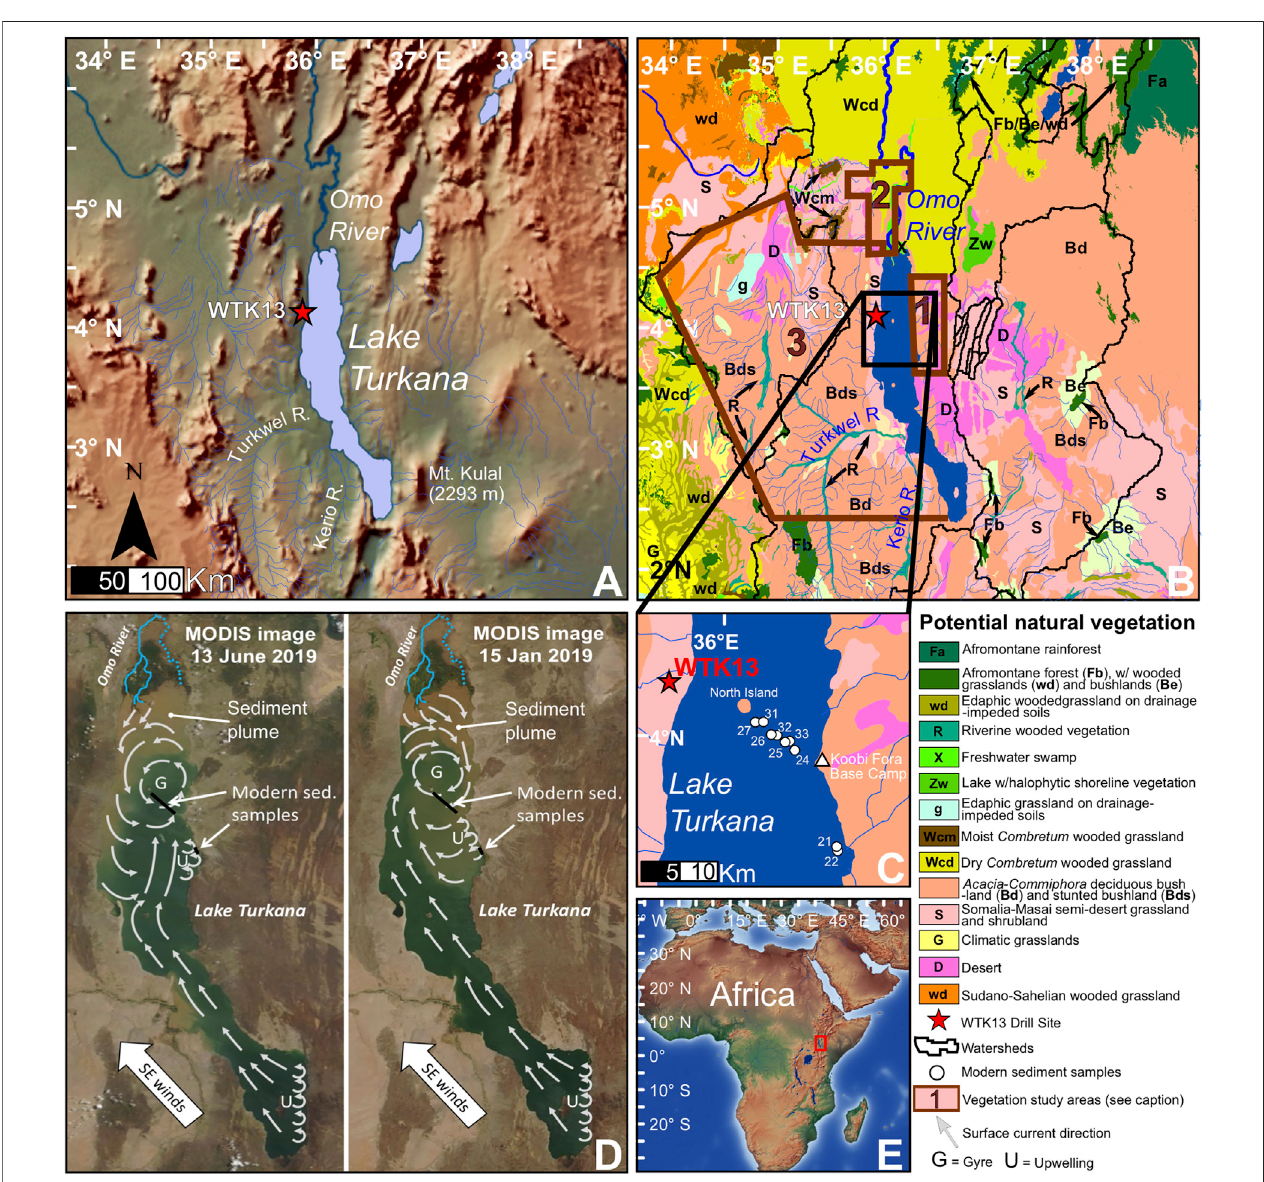
FIGURE 1 | Study area maps. (A) Colored relief map of the Turkana Depression. (B) Potential natural vegetation (PNV; van Breugel et al., 2015) of the Turkana Depression and fl oristic study area boundaries (1 (cid:1) Koobi Fora [East Turkana], 2 (cid:1) Lower Omo River Valley, 3 (cid:1) West Turkana). (C) Modern Lake Turkana sediment sample locations. (D) MODIS satellite images (NASA, 2019) depicting the Omo River sediment plume, and inferred surface currents redrawn from Yuretich and Cerling (1983). (E) Colored relief map of Africa with the Turkana Basin location indicated with the red box.